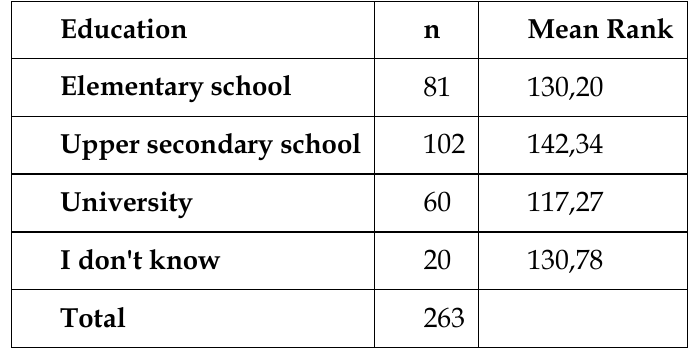
Figure 14. Willingness to use the Digital Health Centre and education. Percentage per reported value on scale 5-1. Elementary school n=81 (100%), Upper secondary school n=102 (100%), University or higher n=60 (100%), I don’t know n=20 (100%). Total n=263. Among the two categories with more respondents, those who reported ‘Upper secondary school’ stated the highest willingness to use the Digital Health Centre. Table 31. Willingness to use the Digital Health Centre and education. Kruskal-Wallis mean rank.